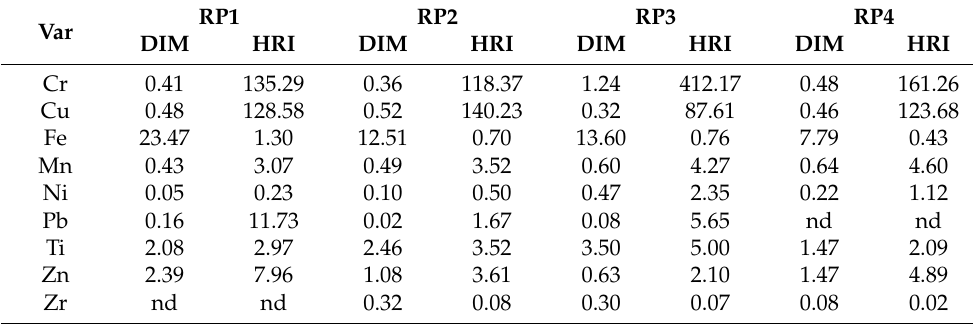
Table 7. Daily elemental intake (DIM) and hazard risk index (HRI).